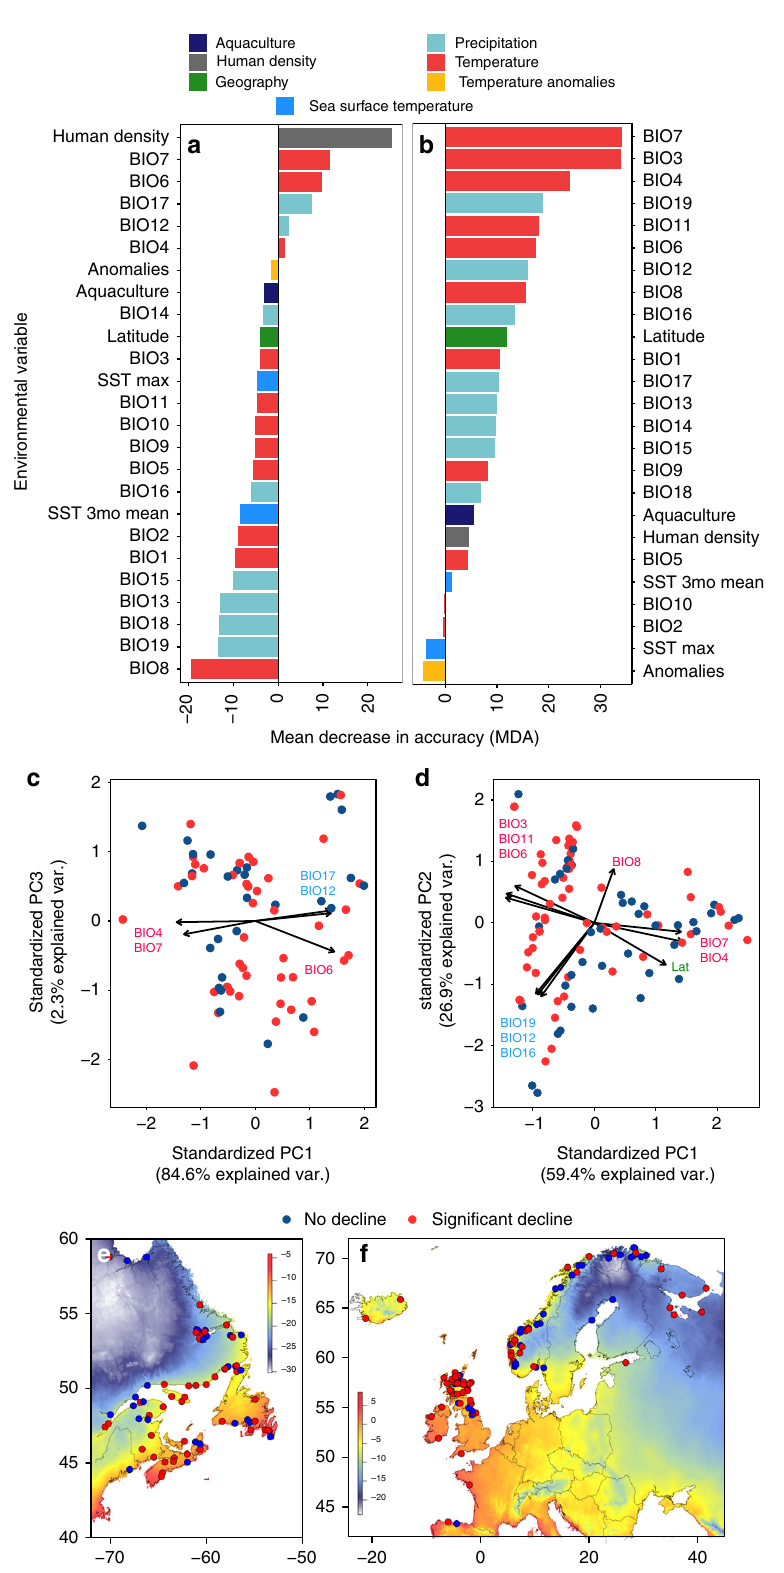
Fig. 2 Environmental and anthropogenic associations with changes in effective population size of Atlantic salmon. Results of random forest (RF) classi fi cation for ( a ) North America and ( b ) Europe showing the environmental and anthropogenic variables arranged by decreasing mean decrease in accuracy (MDA). MDA values represent how the accuracy of RF decreases when the variable is excluded, thus higher values indicate greater importance. Codes for each variable are found in Supplementary Table 2. Principal component analyses (PCA) were performed to show relationships among top (positive) environmental variables within each continent ( c , d ) with panels showing PC axes correlated with population declines. Maps show variation in temperature (°C) measure (BIO6; minimum temperature in coldest month) that loaded high on signi fi cant PC axes, which, among other variables, correlated with declines in both continents ( e , f